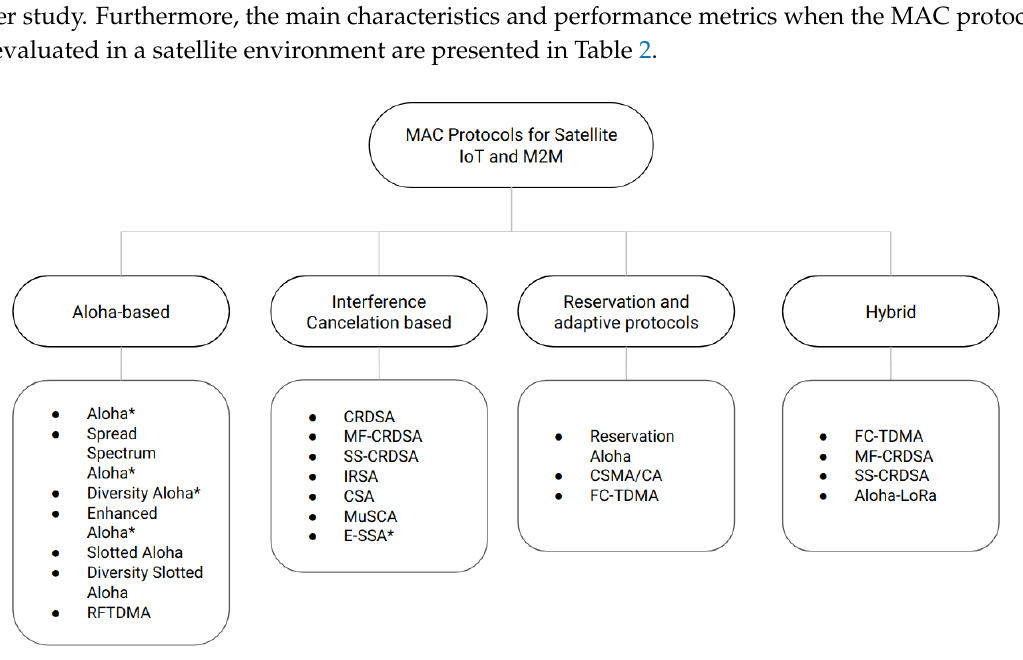
Figure 13. Taxonomy of random access protocols evaluated for satellite systems based on nanosatellites for IoT connectivity. Protocols with * indicate no time synchronization is